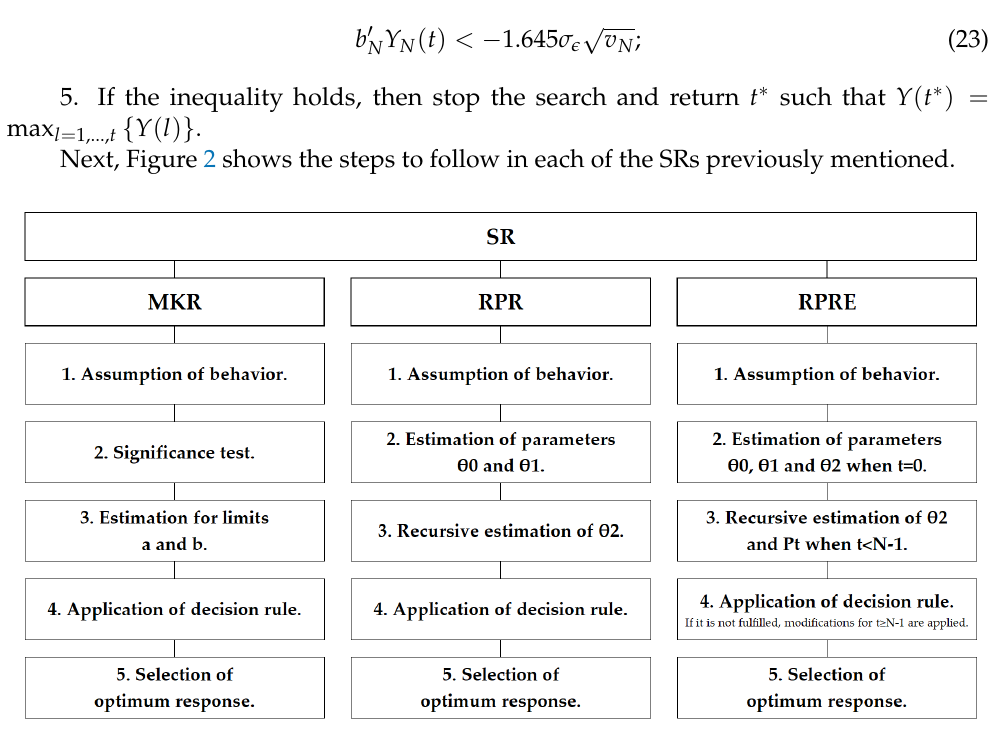
Figure 2. Flow chart that relates the steps needed to develop the MKR, RPR and